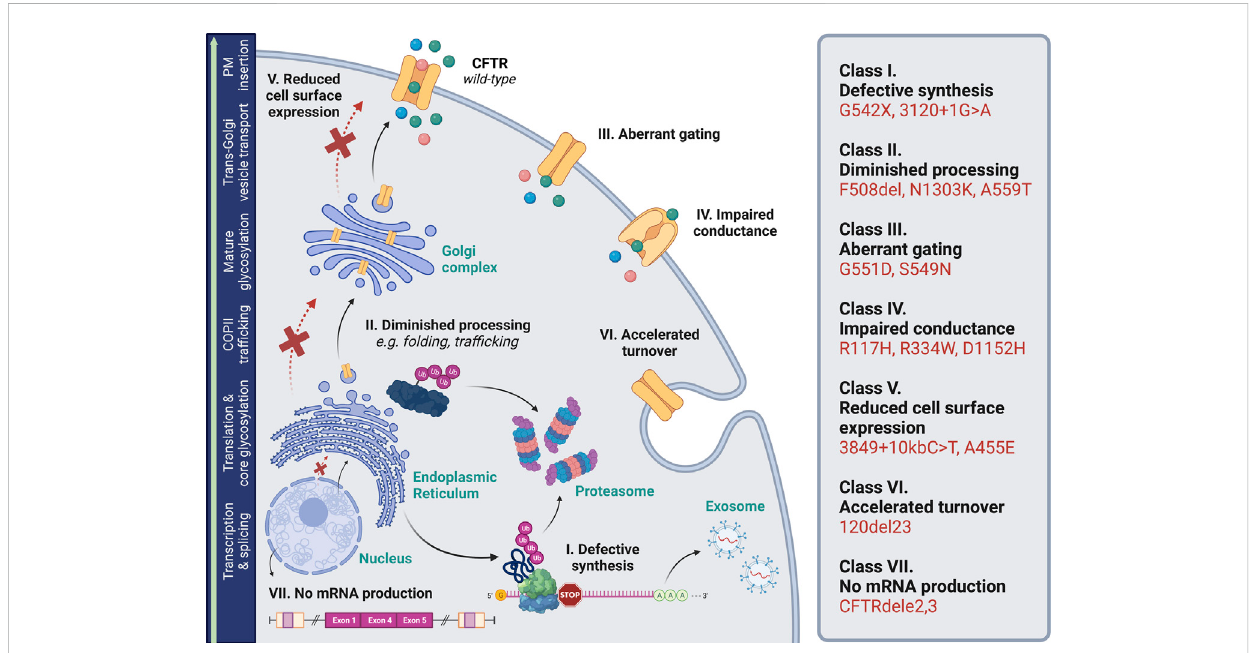
FIGURE 1 Biosynthetic pathway of CFTR. This ATP-binding cassette class-C transporter facilitates ef fl ux of chloride (green molecule), bicarbonate (pink molecule), and water (blue molecule) across the plasma membrane (PM). Biogenesis encompasses transcription and splicing in the nucleus; translation, folding, and core glycosylation at the endoplasmic reticulum; transport to and through the Golgi, including further glycosylation and other post- translational modi fi cations; and vesicular delivery to the cell surface. CFTR variants disrupt one or more steps in this pathway, and thus, are categorized into seven sub-classes based on molecular features (De Boeck and Amaral, 2016; Cottrill et al., 2020). These include defects in: (I) protein synthesis (e.g., nonsense codons, splice variants); (II) processing (e.g., folding abnormalities); (III) channel gating; (IV) ion conductance through a malformed pore; (V)expression atthecellsurface(defects intraf fi cking aredenotedwith ared “ X ” );(VI)plasma membrane stabilityand turnover;and(VII) mRNA production. Abbreviations: coat protein complex II (COPII); ubiquitin (Ub); premature termination codon ( “ stop ” ). Image was generated using